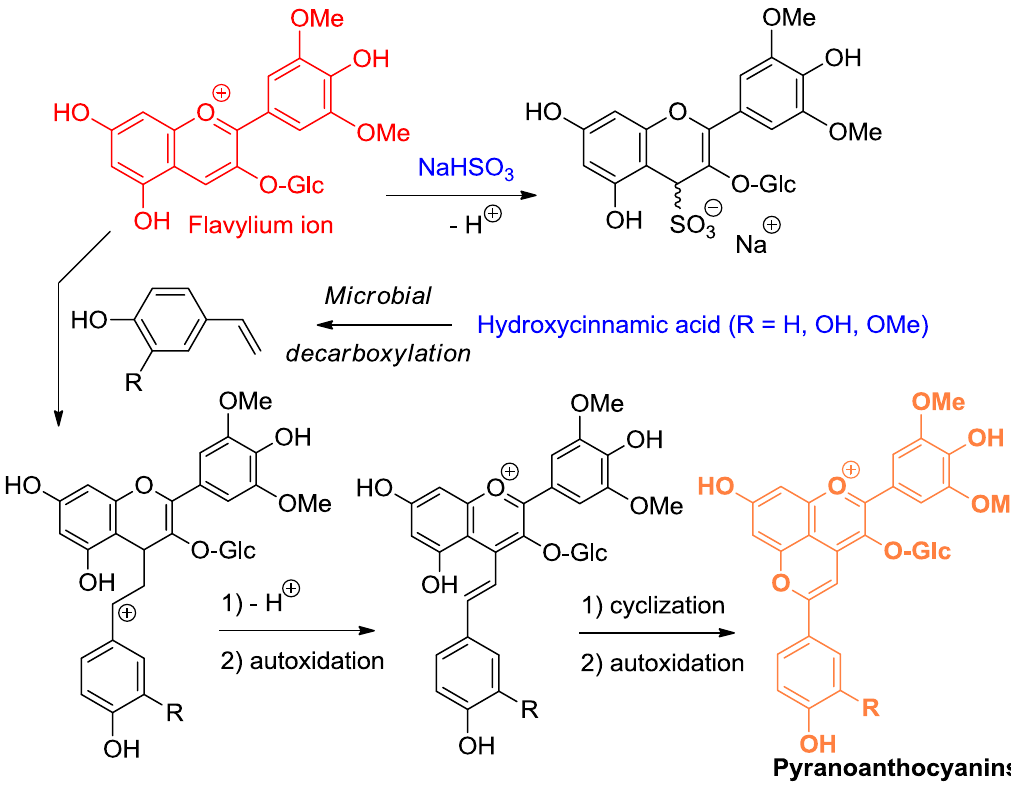
Figure 6. Flavylium ions are soft electrophiles that react at C4 with S- and C-centered nucleophiles, such as bisulfite and 4-vinylphenols.